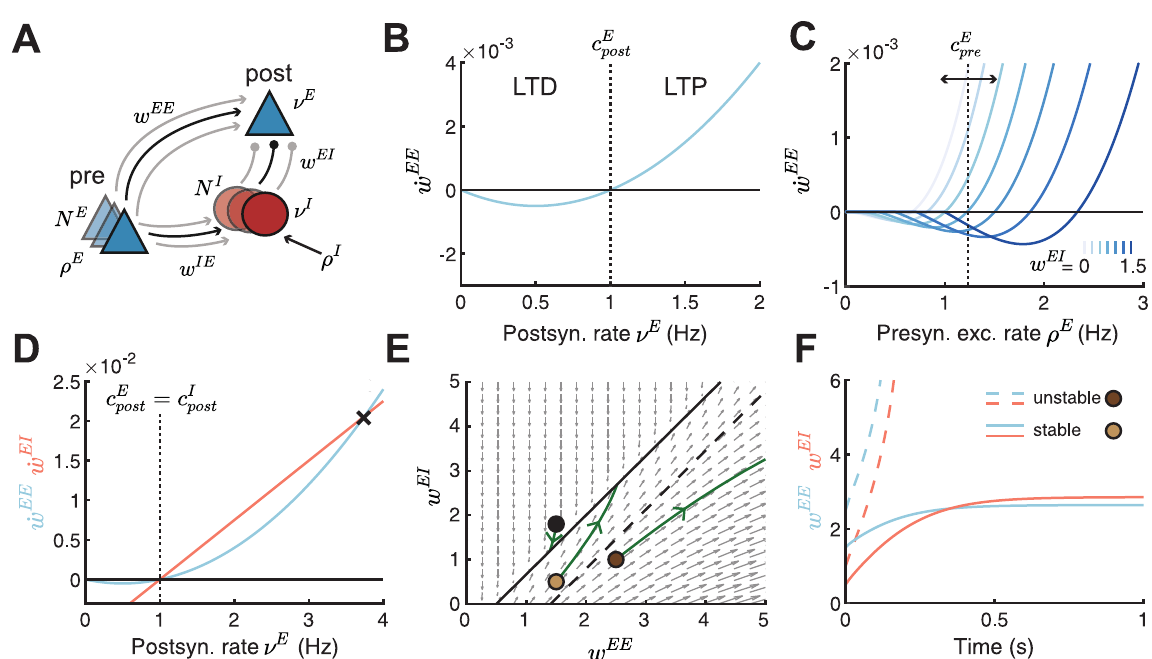
Fig 1. Linear inhibitory plasticity fails to stabilize weights for high postsynaptic firing rates. A . Schematic of a feedforward inhibitory motif. A single postsynaptic excitatory neuron with rate ν E receives input from N E excitatory presynaptic neurons, with firing rate ρ E and weight w EE and N I inhibitory presynaptic neurons, with firing rate ν I and weight w EI . The inhibitory neurons receive external excitatory input with rate ρ I and input from the presynaptic excitatory neurons via w IE . B . Plasticity curve of E-to-E weights ( _ w EE , blue) as a function of the postsynaptic rate is set to 1. C . E-to-E weight change ( _ w EE ) as a function of the presynaptic excitatory rate ρ E for ν E . The postsynaptic LTD/LTP threshold c E post different I-to-E weights w EI ranging from 0 to 1.5. The presynaptic LTD/LTP threshold c E is shown for w EI = 0.75 (vertical dashed line). D . pre Plasticity curves of E-to-E ( _ w EE , blue) and I-to-E ( _ w EI , red) weights as a function of the postsynaptic rate ν E . The excitatory and inhibitory LTD/ LTP thresholds are identical ( c E ¼ c I ). The black cross marks the postsynaptic rate where the plasticity curves cross beyond which the weight post post dynamics become unstable. E . Phase portrait of the dynamics of E-to-E ( w EE ) and I-to-E ( w EI ) weights. Gray arrows indicate the direction of weight evolution over time, points represent three different weight initializations, ½ w EE ; w EI � ¼ f½ 1 : 5 ; 1 : 8 � ; ½ 1 : 5 ; 0 : 5 � ; ½ 2 : 5 ; 1 �g , and green lines 0 0 represent the weight evolution for each case. The two colored points represent initial weights in F. Black line indicates the line attractor and the dashed line separates stable from unstable initial conditions (Methods, Eq 20). F . E-to-E ( w EE , blue) and I-to-E ( w EI , red) weights as a function of time for stable (solid lines, ½ w EE ; w EI � ¼ ½ 1 : 5 ; 0 : 5 � ) and unstable (dashed lines, ½ w EE ; w EI � ¼ ½ 2 : 5 ; 1 � ) initial conditions. 0 0 0 0